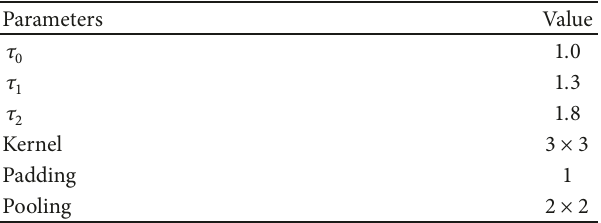
Table 2: Parameters for EISATS